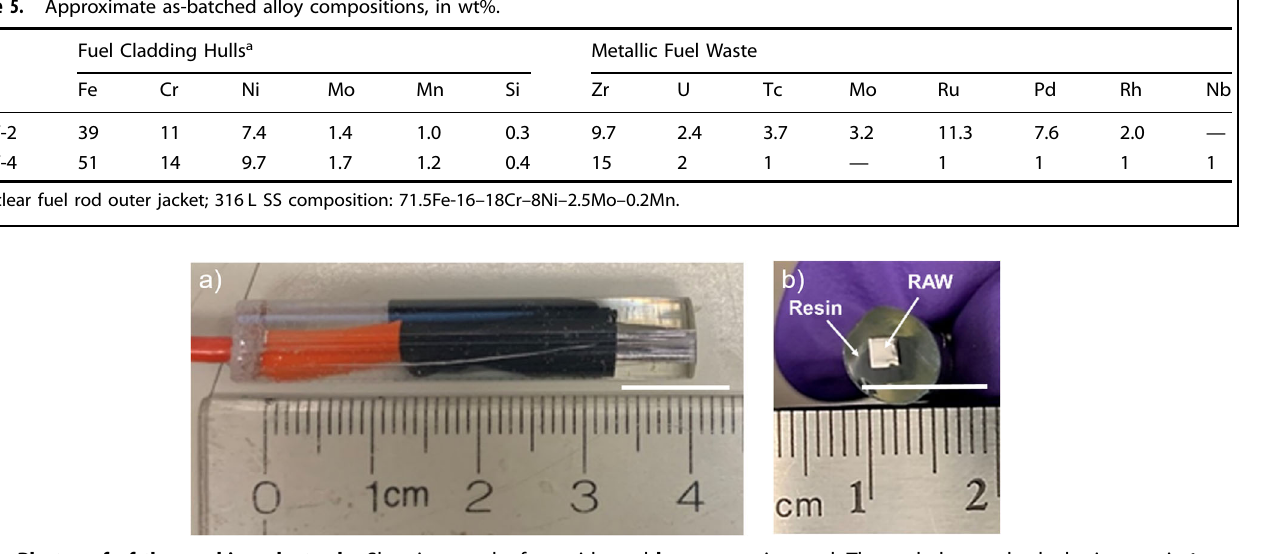
Fig. 6 Photos of of the working electrode. Showing results for a side and b cross-section end. The scale bar on both the images is 1